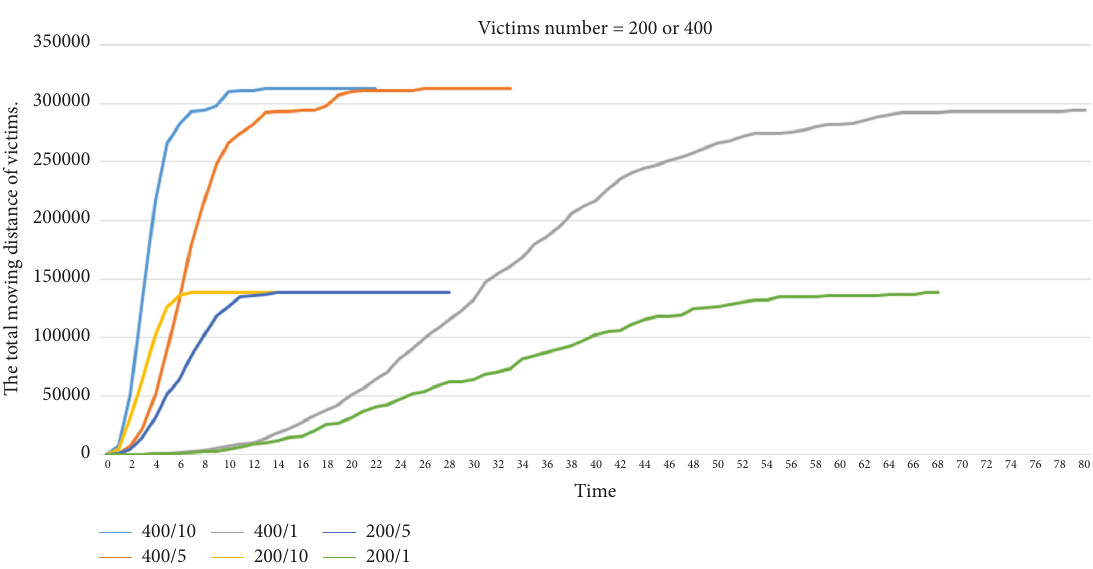
Figure 14: The number of the saved victims over time (victim number � 400).